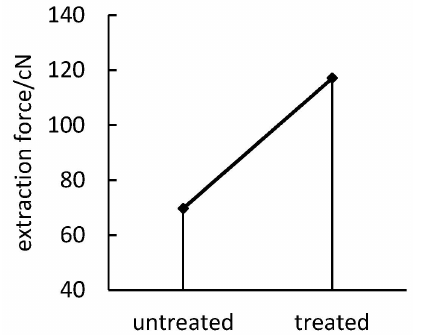
Figure 3. Comparison of extraction force before and after plasma